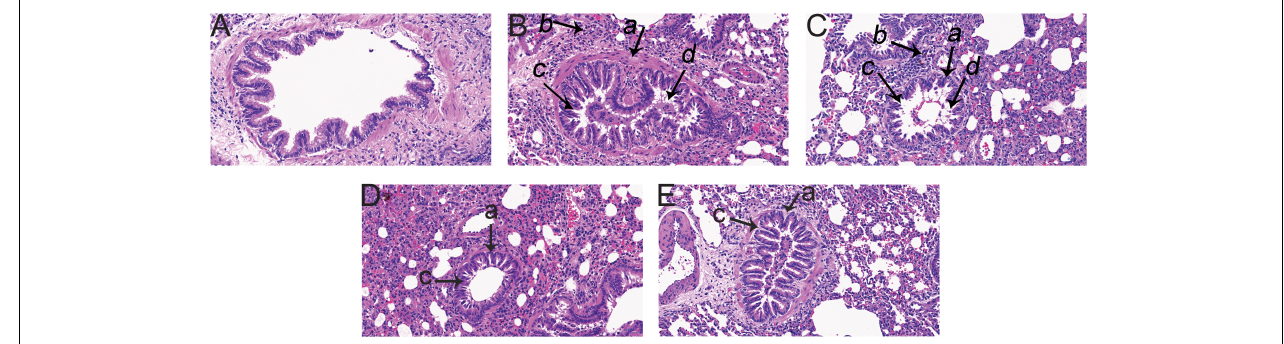
FIGURE 1 | Pathological changes in lung tissue observed by hematoxylin and eosin (HE) staining (Light microscopy, × 200). 4.86 g/kg Gan Jiang and 21.6 g/kg of Linggan Wuwei Jiangxin (LGWWJX) decoction significantly reduced inflammation and pathological changes compared with the model group. LGWWJX decoction alleviated airway wall thickening and inflammatory cell infiltration to a greater extent than GJ. (A) control; (B) model; (C) Gan Jiang (GJ, 4.86 g/kg); (D) LGWWJX decoction (LGWWJX, 21.6 g/kg); (E) postive control (PC, Guilong Kechuanning, 2.43 g/kg ). (a) airway wall; (b) inflammatory cell infiltration; (c) airway luminal narrowing; (d) mucous